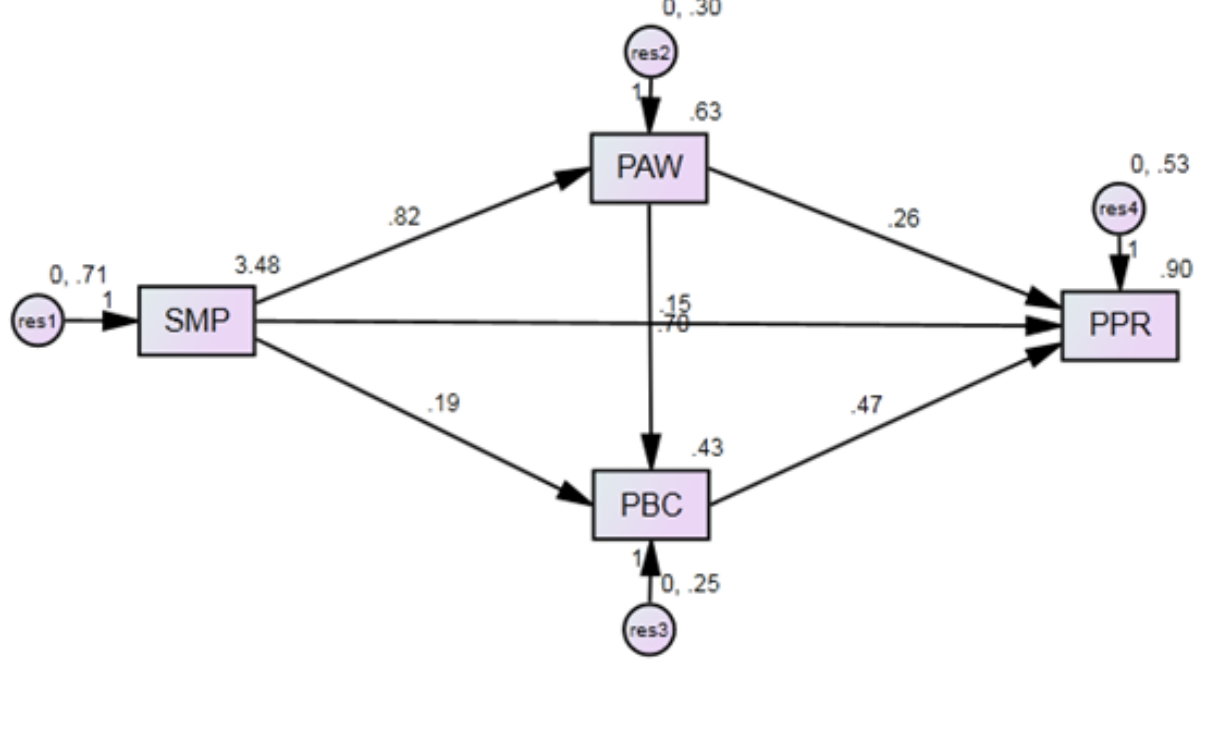
Figure 3. Estimated path values for the hypothesized structural